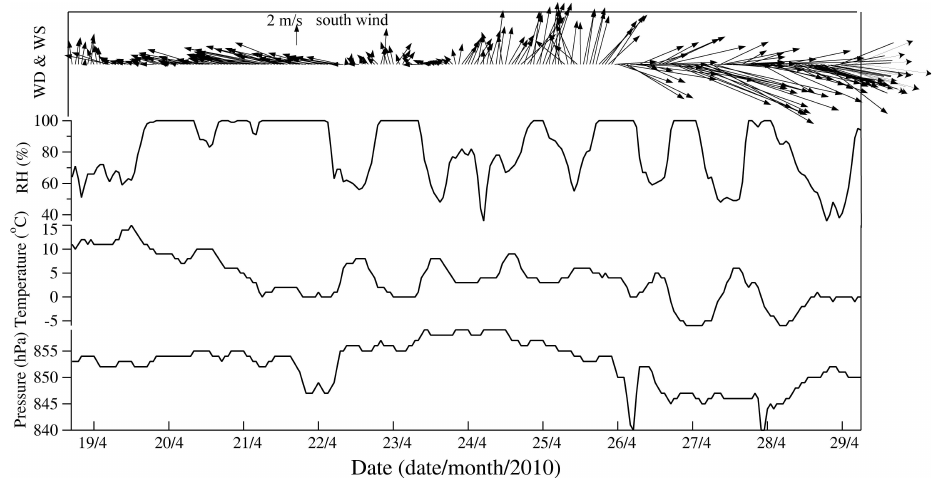
Fig. 2. Continual variations of wind speed (WS), wind direction (WD), relative humidity (RH), temperature, and pressure monitored at the summit of Mt. Tai during 19–29 April,